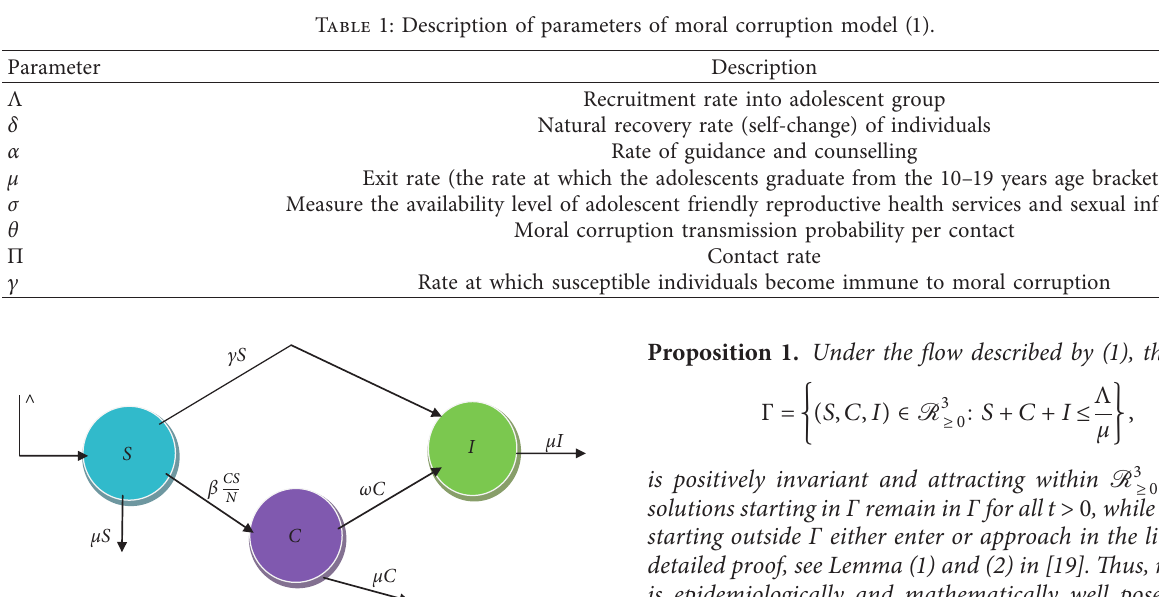
Figure 1: Schematic diagram of the corruption transmission dy- namic